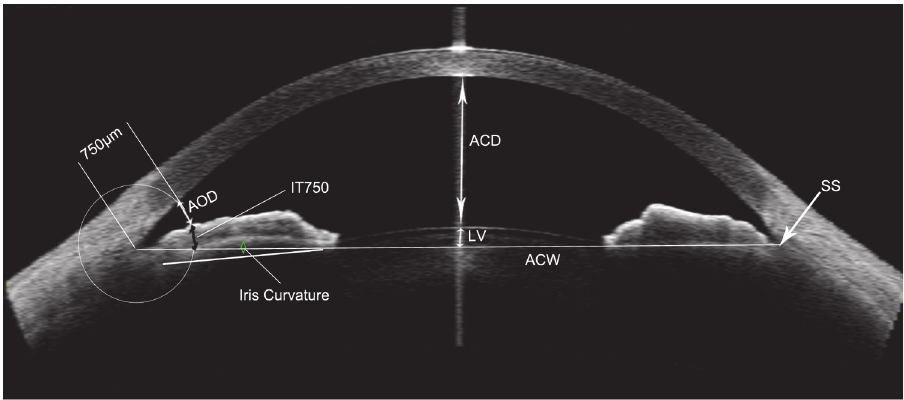
Fig 1. AS-OCT measurement. AS-OCT image showing the measurements of scleral spur (SS), ACD, ACW, LV, AOD750, IT750, and iris curvature.